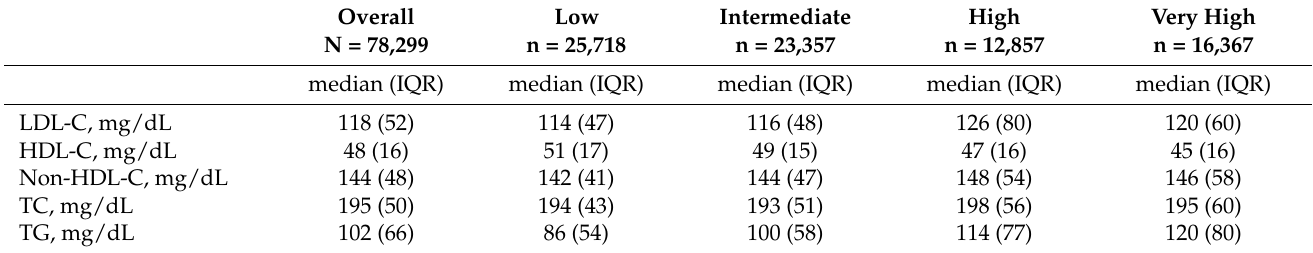
Table 3. Lipid panel for patients in every cardiovascular risk category on 31 December